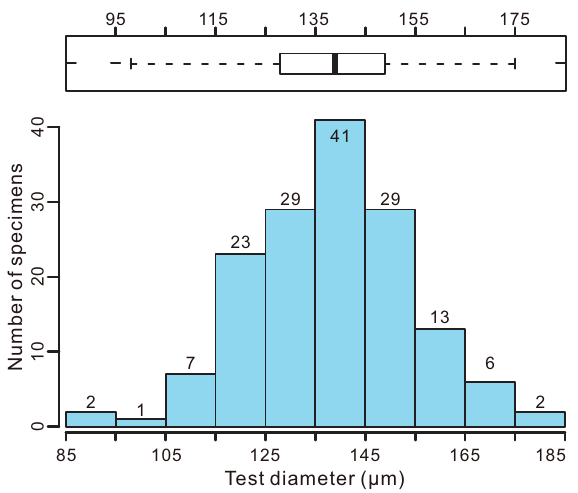
Fig. 5. Histogram of the average diameter of Vikisphaera kundana gen. et sp. nov. from the type locality, Viki core, depth 360.9– 361.1 m, sample